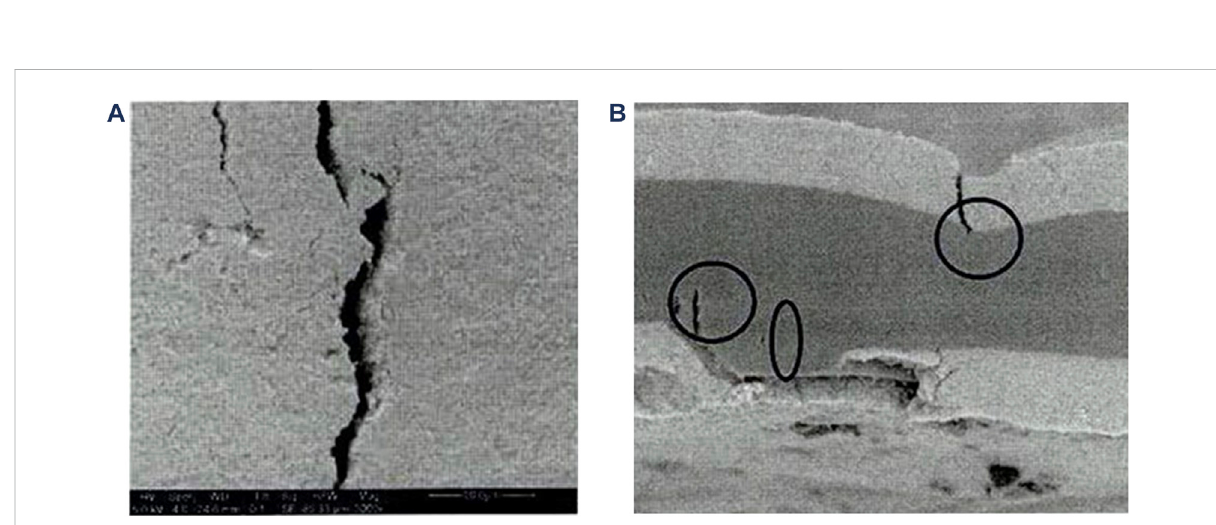
FIGURE 7 Morphology of an CCM investigated using SEM to observe the surface topography. (A) The surface of the CCM displaying a crack in the electrode layer. (B) A cross-sectional micrograph displaying how the electrode cracking is penetrating the CCM and the beginning of a pinhole/ tearing of the membrane. Reproduced with permission from LaConti et al.